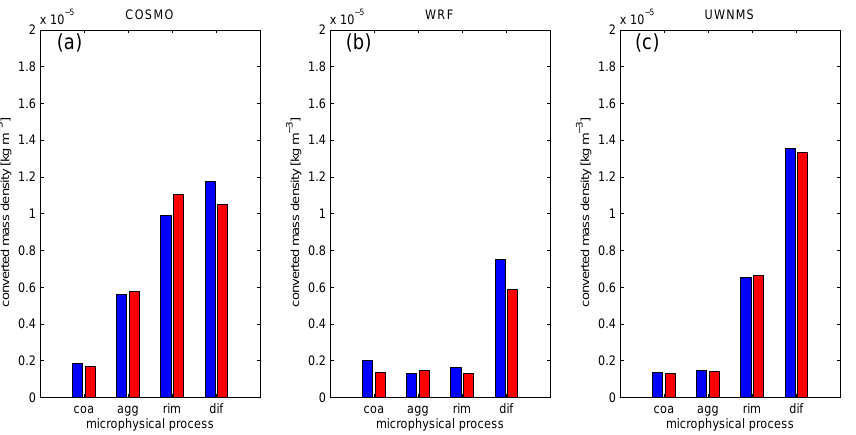
coa agg rim Fig. 10. Mass density of cloud liquid and ice converted to precipitable hydrometeors by coalescence (coa), aggregation (agg), riming (rim) and diffusional growth (dif) for the clean case simulation SIM 1 CC (blue) and the polluted case simulation SIM 1 PC (red) in COSMO (a) , WRF (b) and UWNMS (c) . In the bulk microphysics schemes, where cloud droplets and rain drops are artificially differentiated according to size, the coalescence term includes contributions from autoconversion and accretion. The diffusional growth term includes condensation, deposition, evaporation and sublimation. All values are integrated over the 10h simulation